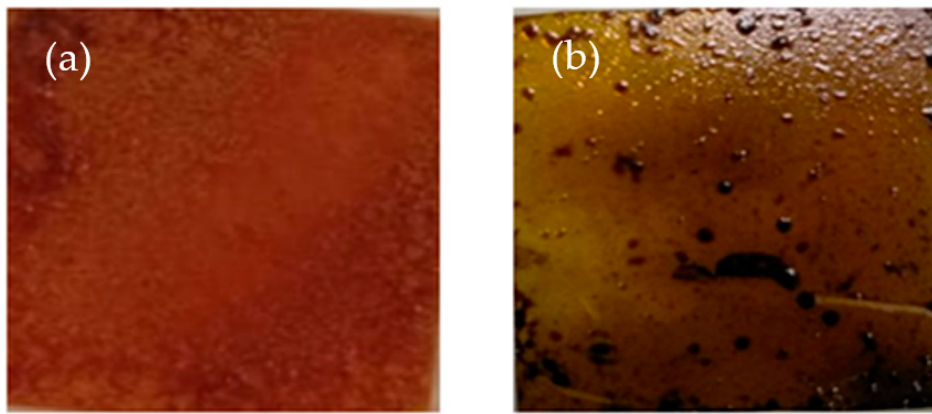
Figure 2. Final obtained substrates of ( a ) N -AMP and ( b ) I -AMP.